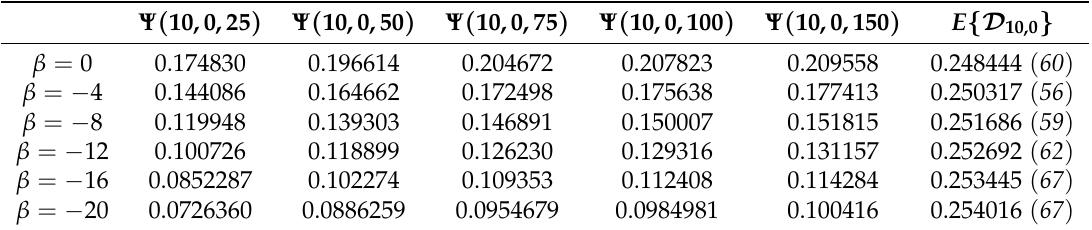
Table 1. Finite-time ruin probabilities and expected total discounted dividends paid prior to ruin